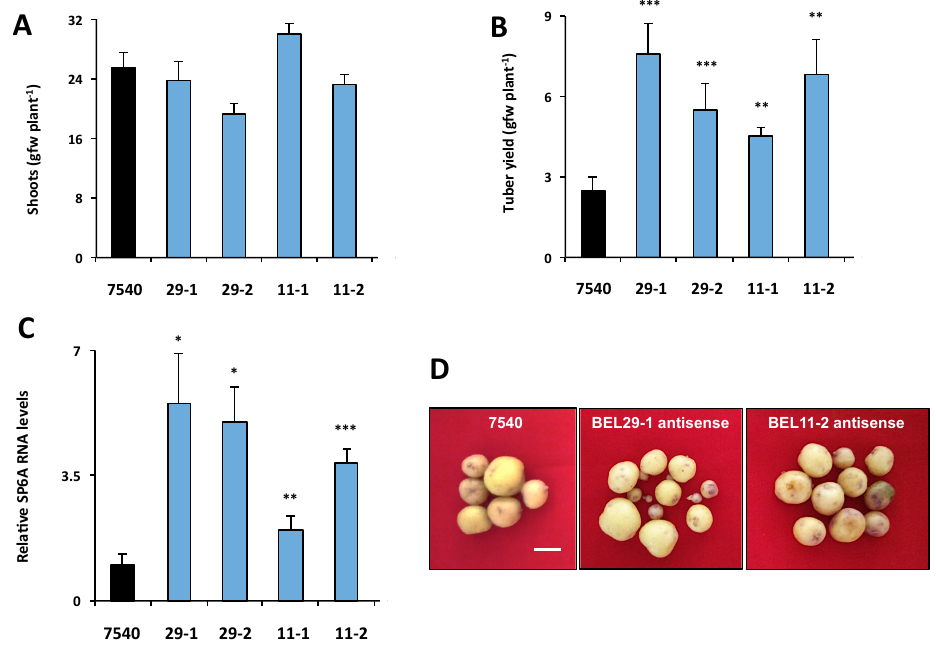
Figure 7. Phenotype of RNA antisense lines for StBEL11 (11-1, 11-2) and StBEL29 (29-1, 29-2). After screening, select independent lines were grown for eight weeks under long days and then 21 d under SD conditions, harvested and scored for shoot growth ( A ) and tuber yields ( B ). Andigena line 7540 is a non-transformed WT line. For analysis of the tuber target gene, StSP6A ( C ), RNA was extracted from 21-day SD stolons and quantified using RT-qPCR with gene-specific primers. Error bars represent ±SD of five plants for the whole plant analysis and two biological replicates for the RT-qPCR. A Student’s t -test was performed to check significance with one, two and three asterisks indicating p -values of <0.05, <0.01 and <0.001, respectively. Tuber samples from RNA antisense lines for StBEL11 and StBEL29 ( D ). Plants were grown in a growth chamber as described above prior to harvest. For each line, tubers were pooled from three plants. White bar = 1.0 cm. With permission of the publisher [10].